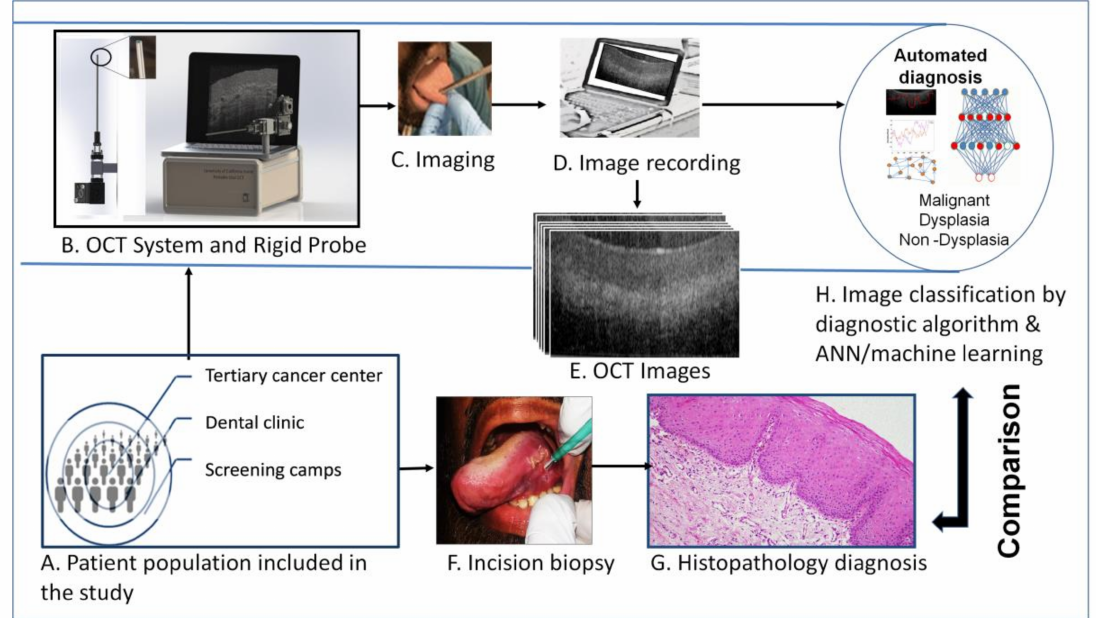
Figure 1. Study design. The subjects were: ( A ) recruited from low resource settings (oral cancer screening camps), dental hospitals and tertiary cancer center. ( B ) A portable Optical Coherence Tomography (OCT) system, ( C )was used to capture oral mucosal lesion images, after oral physician consultation. The OCT images were recorded in laptop and used for image pre-processing and automated image analysis ( D , E ). The subjects underwent incision/excision biopsy (if indicated) for histopathological diagnosis ( F , G ). The OCT images were then analyzed by automated image processing and algorithm/artificial intelligence ( H ) based classification and compared with histological